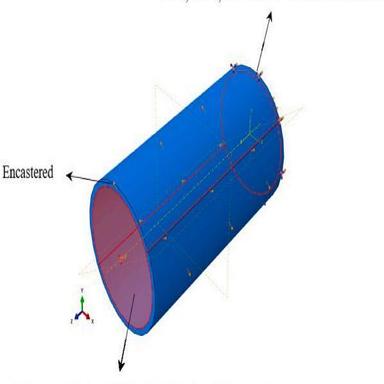
Applied boundary conditions in FEM.